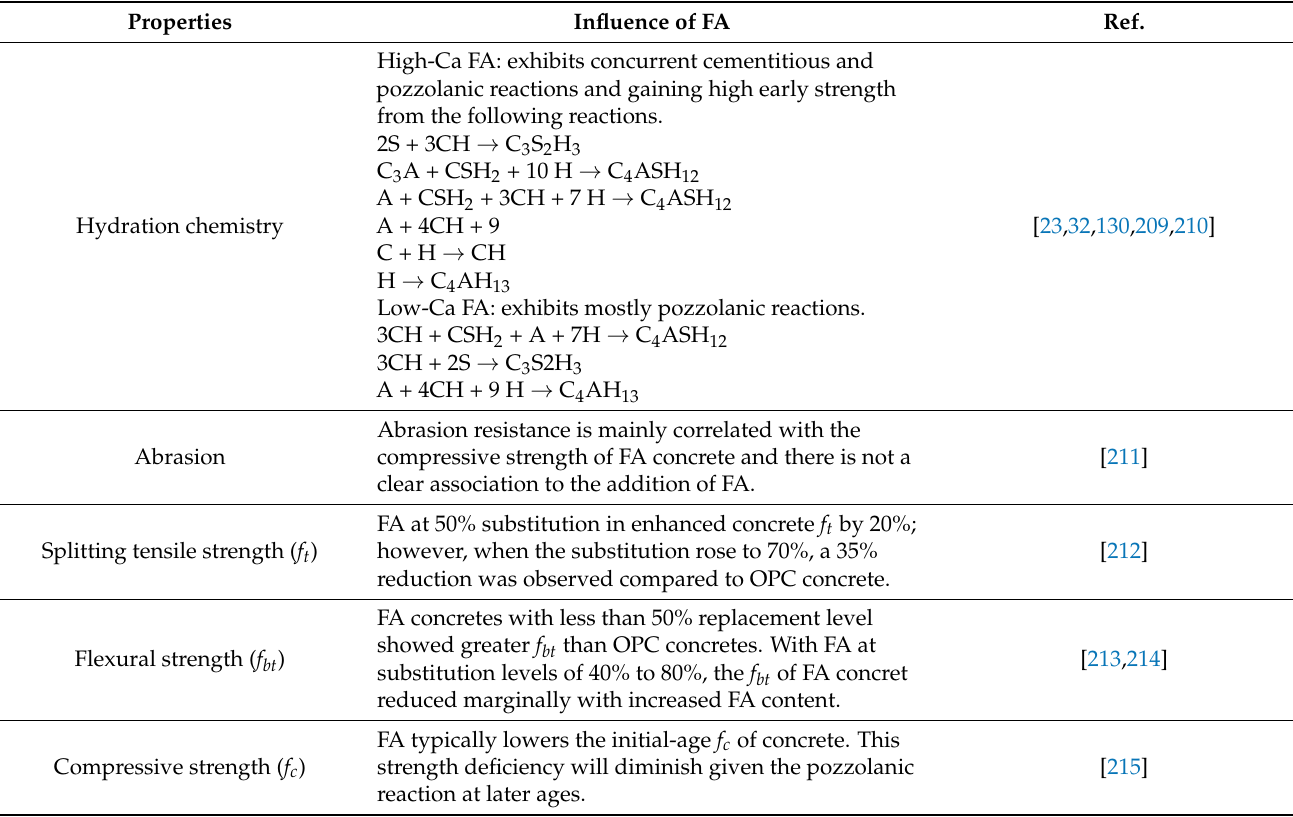
Table 9. Summary of the effect of FA on mechanical properties of